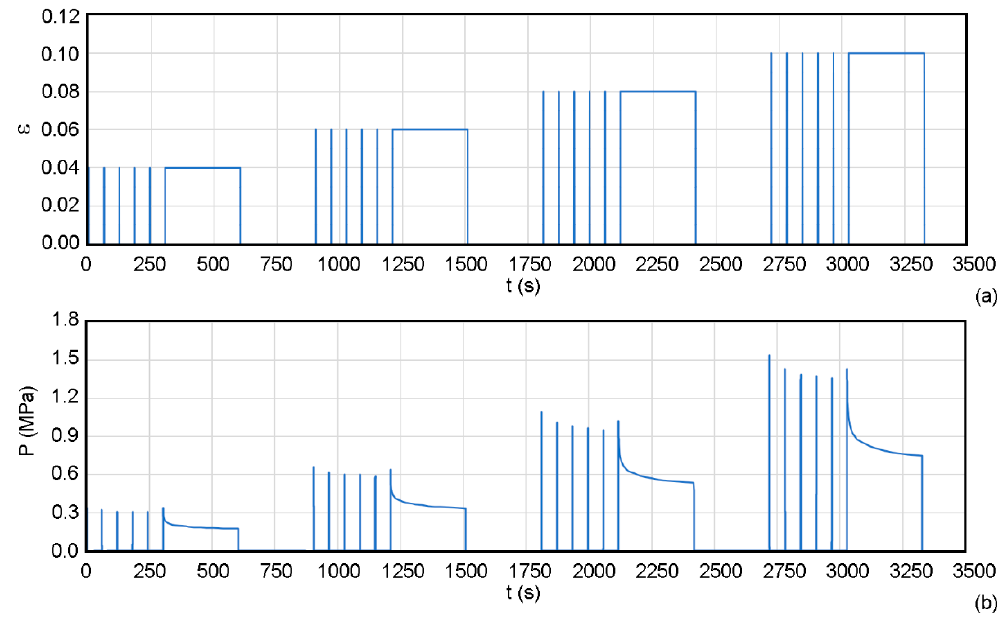
Figure 2. Loading protocol of mechanical tests in terms of nominal strain ε vs. time ( a ) and typical response of a PF sample in terms of nominal stress P vs. time ( b ).